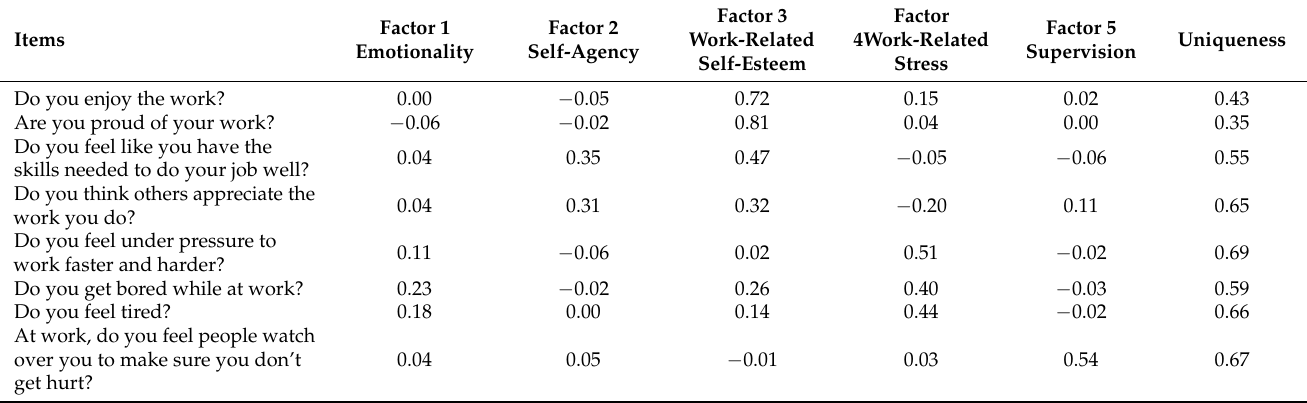
Table A2. Results of factor analysis: rotated factor loadings and uniqueness for the five-factor